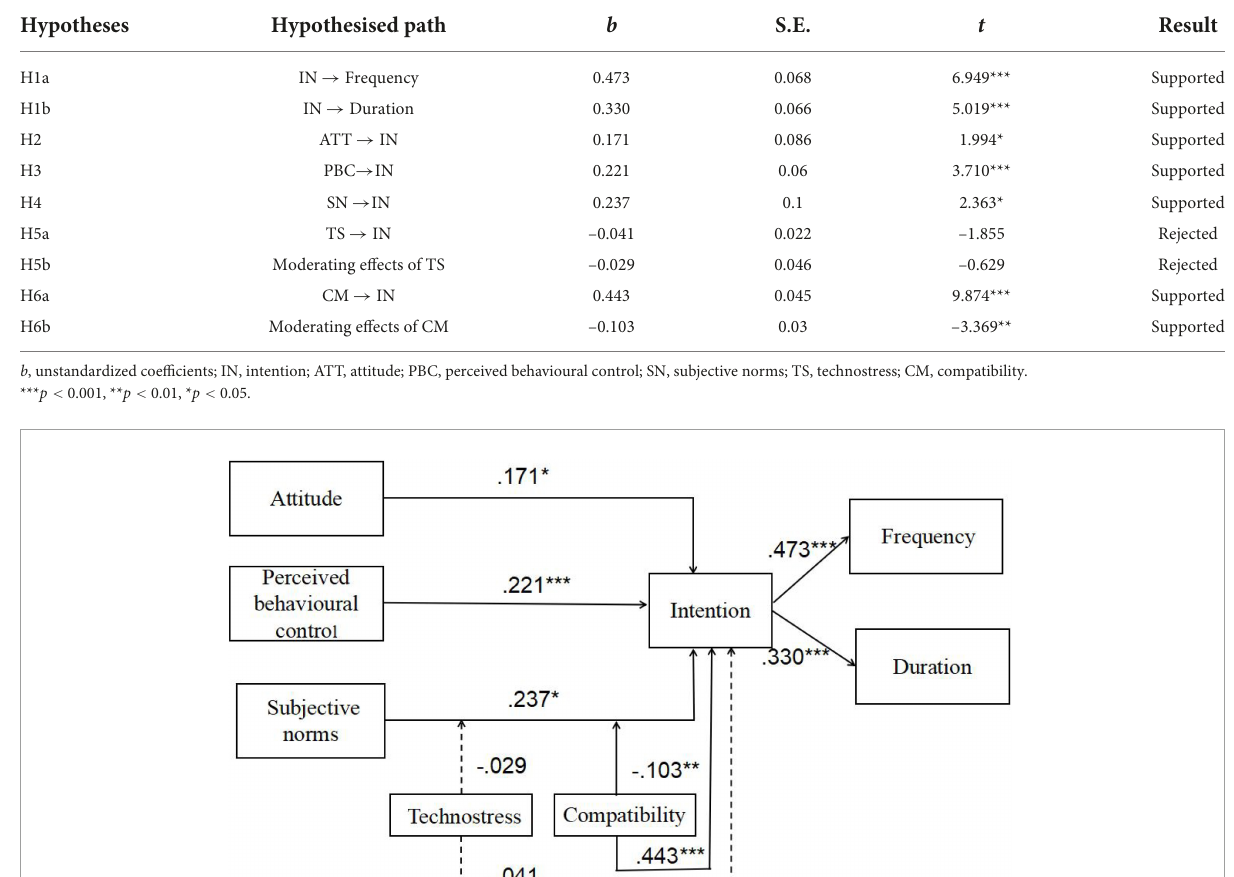
TABLE 4 The results of hypotheses testing.